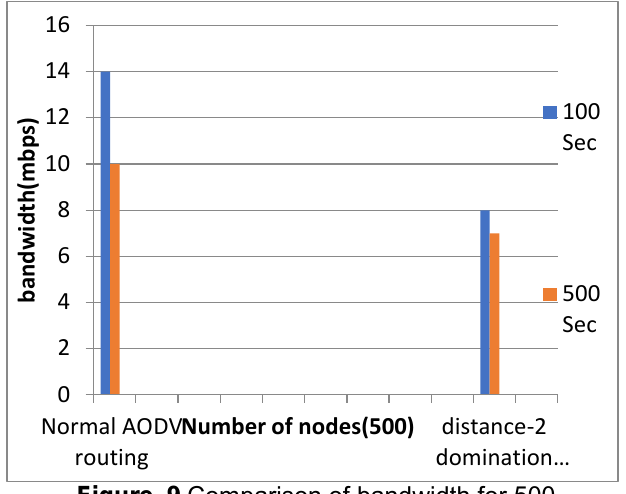
Figure. 9 Comparison of bandwidth for 500